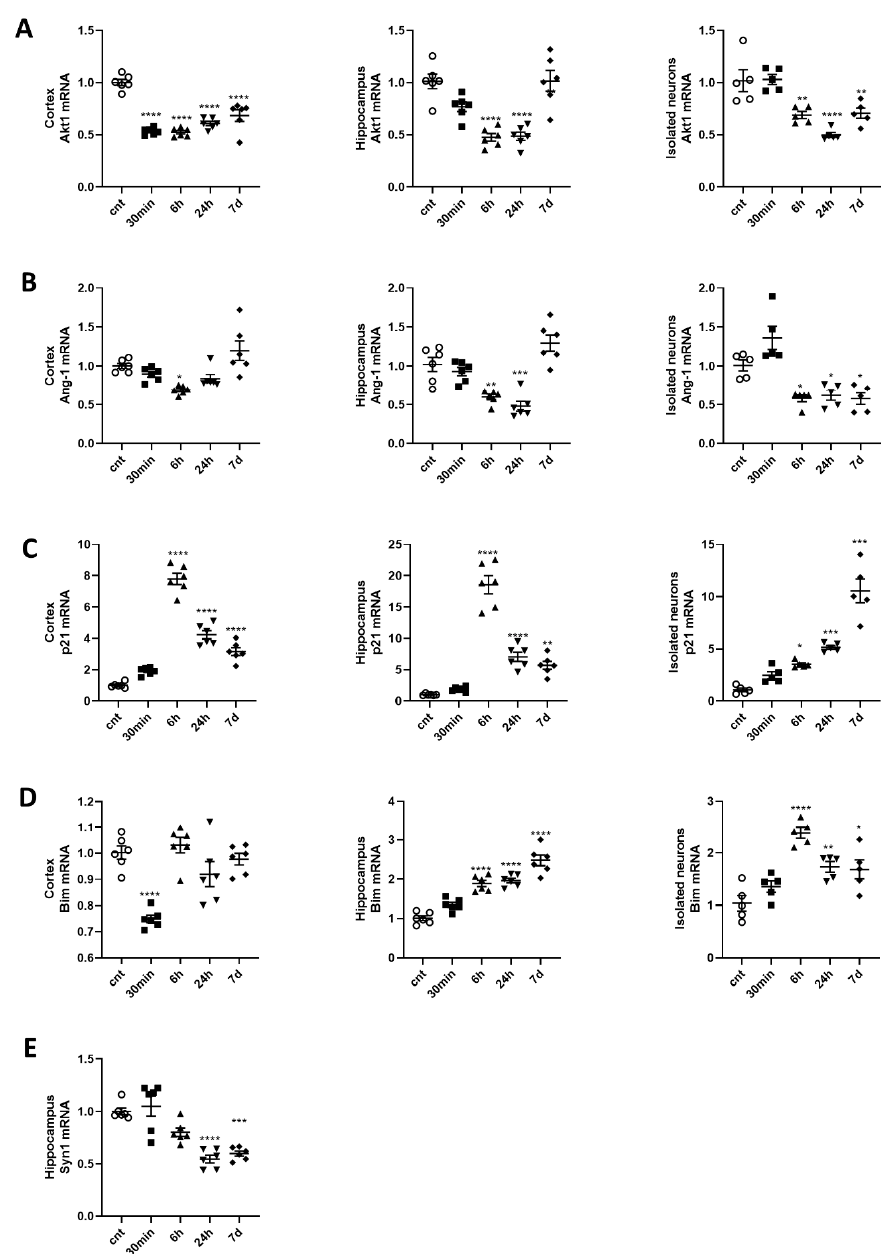
Figure 1. Expression of anti-apoptotic and neuronal marker genes is downregulated, while expression of pro-apoptotic and pro-senescence genes is upregulated, in the cortex, hippocampus and purified neurons after brain irradiation. Experimental rationale and details are described in Experimental Setup. Tissues and neurons were collected at 30 min, 6 h, 24 h and 7 d after 10Gy whole-brain irradiation. Total RNA was used for qPCR analysis. qPCR quantification of ( A ) Akt1 mRNAs in cortex (F (4,25) = 40.18), hippocampus (F (4,25) = 18.50) and isolated neurons (F (4,20) = 15.48); ( B ) Ang-1 mRNAs in cortex (F (4,25) = 8.438), hippocampus (F(4,25) = 20.14) and isolated neurons (F(4,20) = 15.76); ( C ) p21 mRNAs in cortex (F(4,25) = 128.4), hippocampus (F(4,25) = 82.96) and isolated neurons (F(4,20) = 44.66); ( D ) Bim in hippocampus (F(4,25) = 44.84) and isolated neurons (F(4,20) = 11.61) and ( E ) Syn1s (F(4,25) = 19.18) mRNAs in hippocampus. n = 6 / group for tissues, n = 6 / group for isolated neurons, with 2 technical replicates. * p < 0.05, ** p < 0.01, *** p < 0.001, **** p < 0.0001 vs. control animals non irradiated